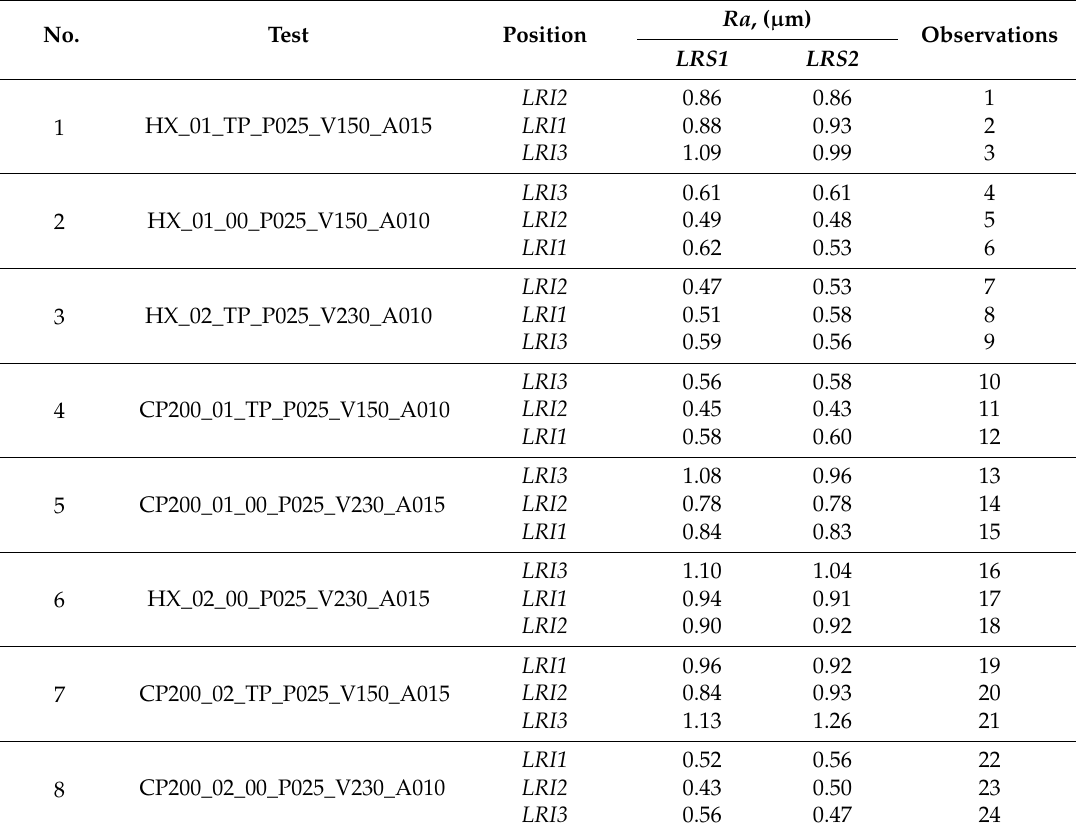
Table 5. Values of the arithmetic mean deviation roughness, Ra ( µ m), obtained during turning tests. No. Test